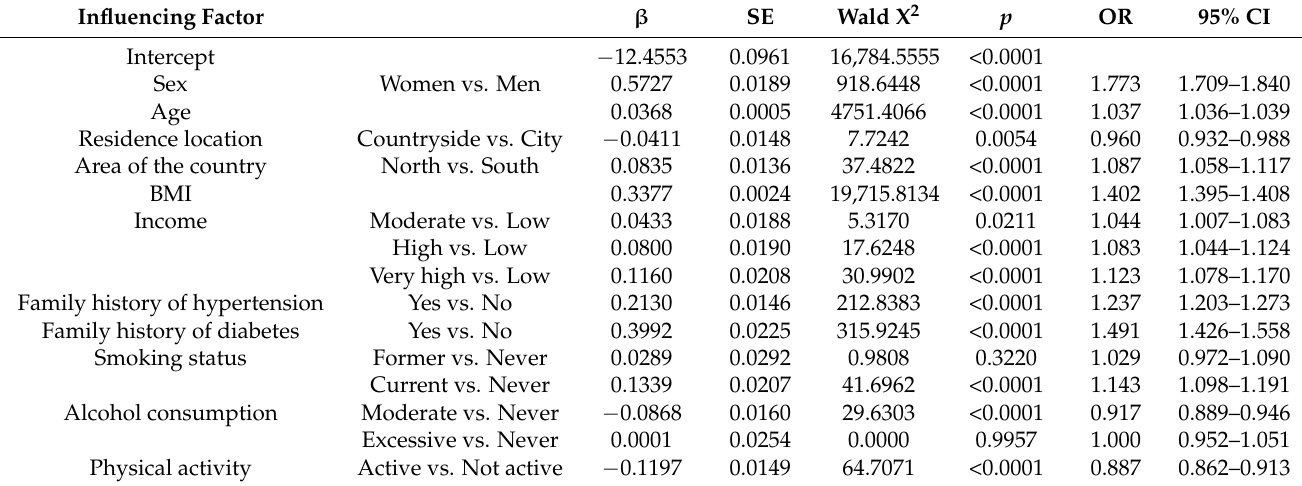
Table 3. Logistic regression analysis results of influencing